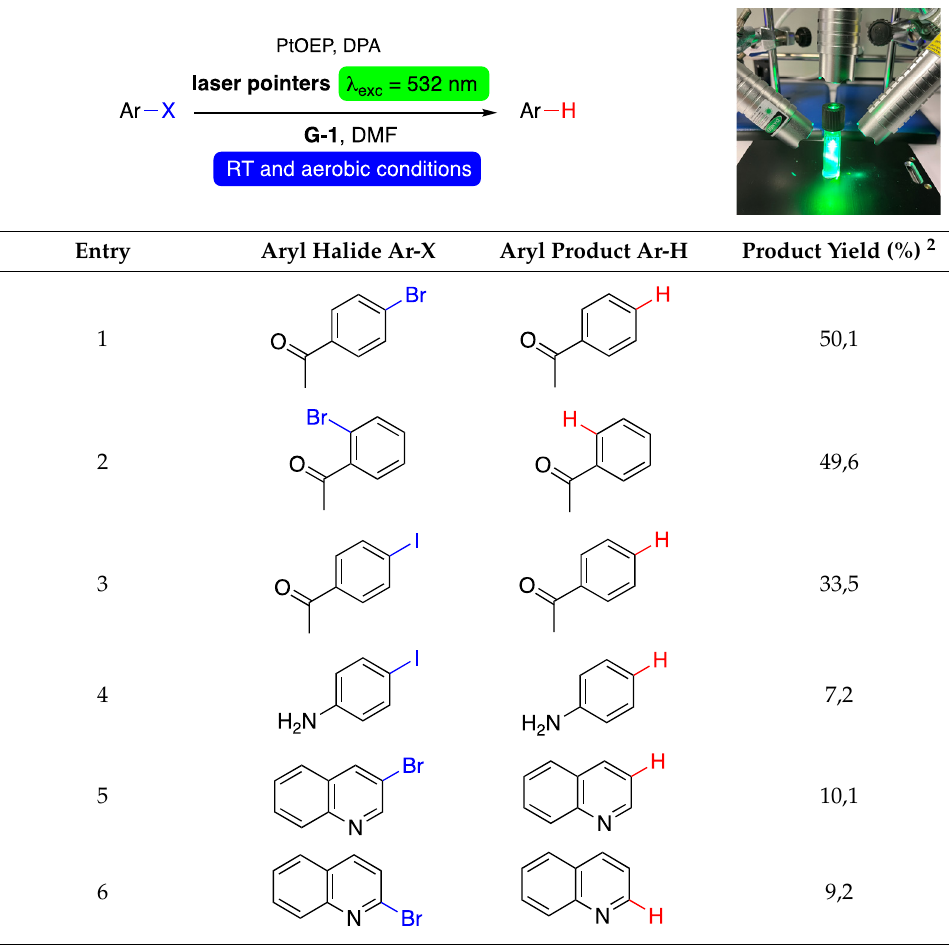
Table 2. Photoreduction of aryl halides using three laser pointers with optimal configuration 1